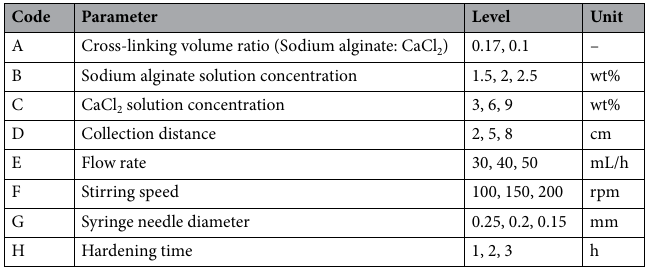
Table 1. Definition and trial levels of factors in Taguchi’s L 18 orthogonal array experiment to fabricate calcium alginate